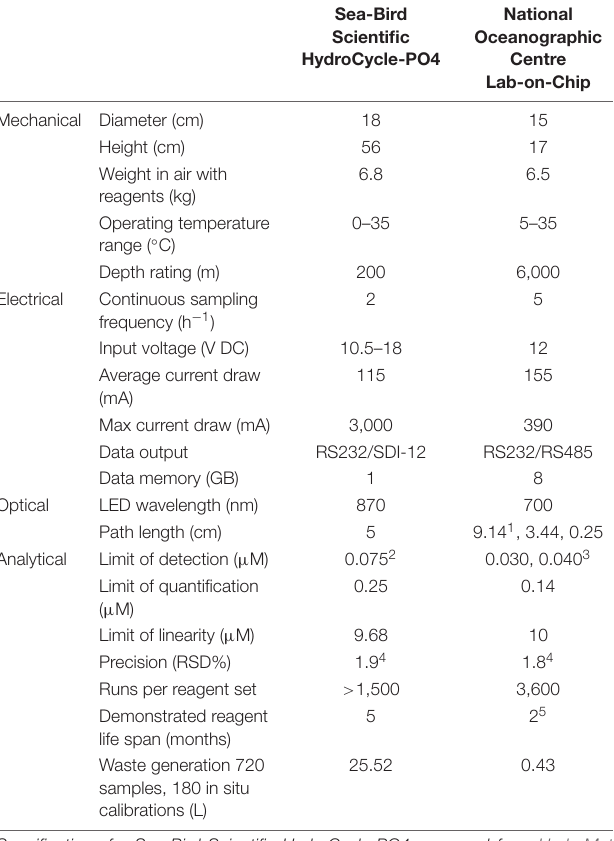
TABLE 1 | Comparison of Sea-Bird Scientific HydroCycle-PO4 commercially available analyser and the National Oceanographic Centre, Lab-on-Chip analyser (AUV integration set up